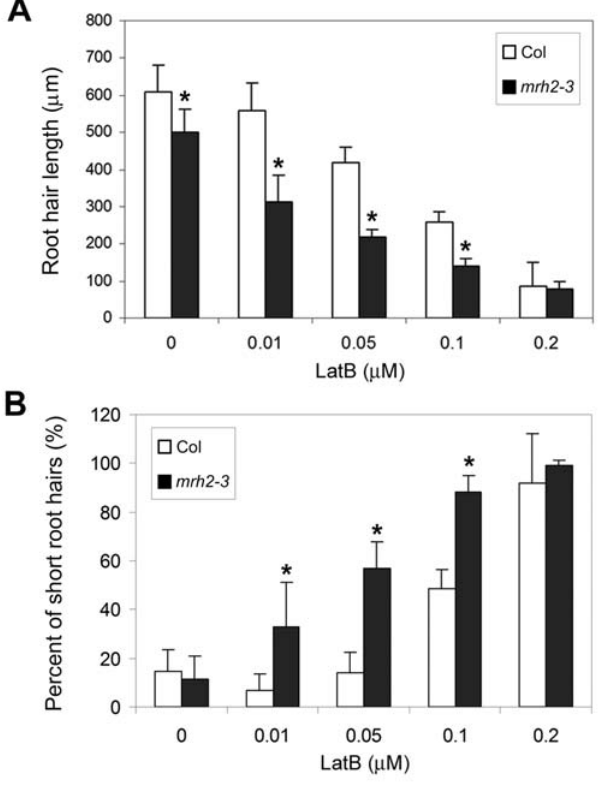
Figure 7. Hypersensitivity of mrh2-3root hairs to LatB. Three-day-old seedlings that were grown in the drug-free medium and then transferred to the LatB-containing medium for two additional days. The solvent DMSO was used as the 0 m M control. Col, the wild-type. (A) Quantitative analysis of mrh2-3 root hair length in response to LatB. A total of 12–15 root hairs for each root (except about five root hairs for 0.2 m M LatB treatment) were measured, and the average and the SD of eight roots are shown. (B) Proportions of short root hairs in mrh2-3 after LatB treatments. The same data as in (A) were analyzed. Root hairs shorter than 220 m m were classified as short root hairs. The asterisk (*) above the column indicates a significant difference (p , 0.05) compared to Col under the same treatment.